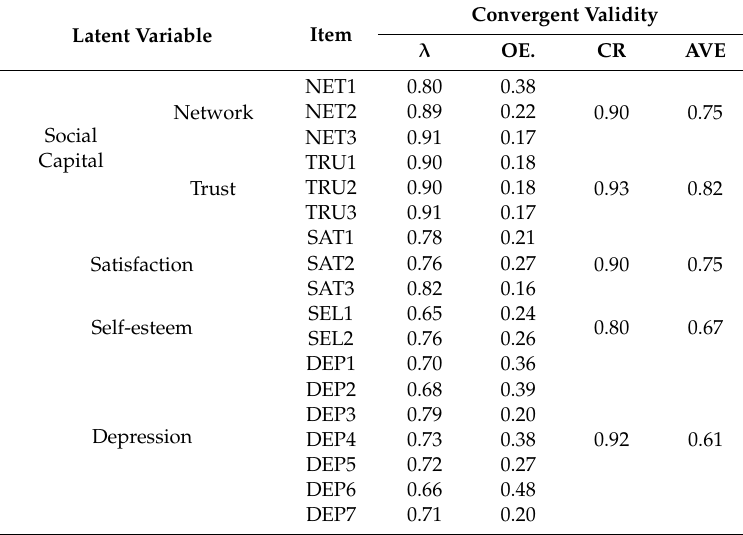
Table 3. Results of the confirmatory factor analysis conducted with scales measuring social capital, social capital satisfaction, self-esteem, and